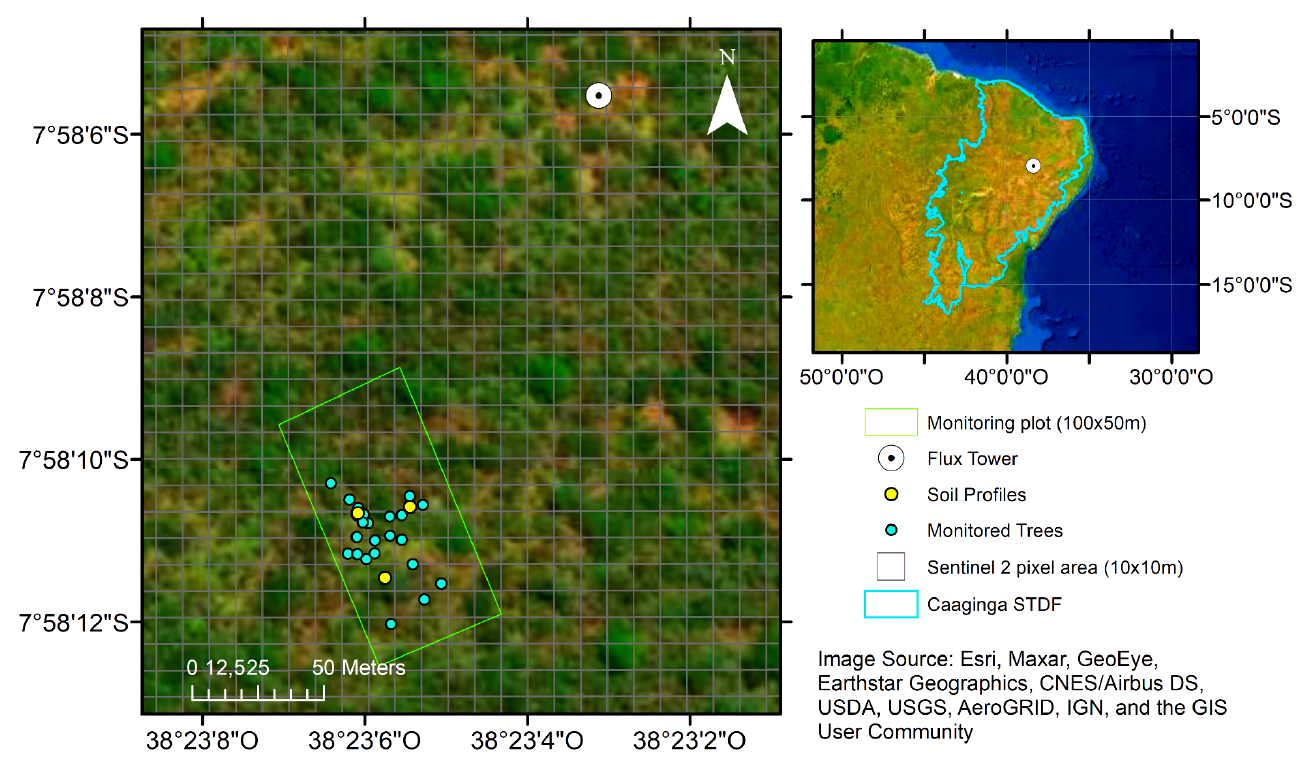
Figure 1. Study site: Map of the study area showing eddy covariance (EC) flux tower location (where the phenocam is installed), and the monitoring plot (where sap flow and soil moisture sensors were installed); location of the study site in the context of the Brazilian Caatinga. Spatial resolution: 15